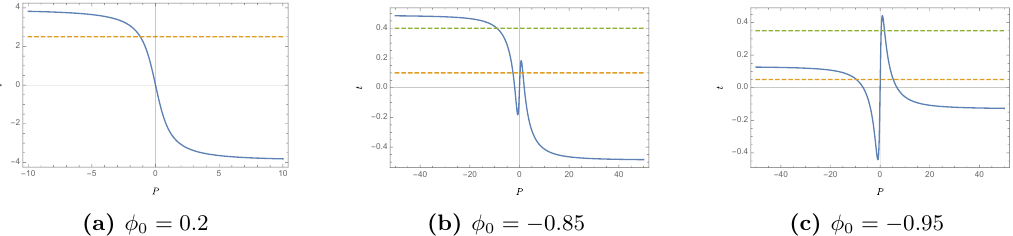
Figure 14. t as a function of P for different values of φ 0 . In each figure, the colours of the dashed lines correspond to those of the relevant geodesics in figure 8. R b is set to 10. In the first plot, each time corresponds to at most a single value of P . In the second plot, at short times there are three relevant values of P (yellow dashed line), while at later times, there is only one relevant value of P (green dashed line). In the last plot, the yellow dashed line shows again three relevant values of P , but the green line intersects at two different values of P